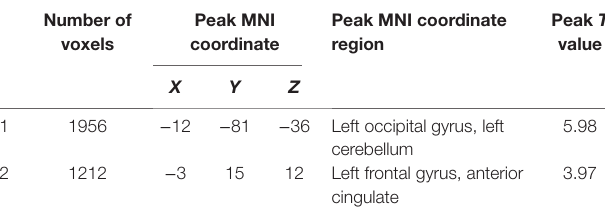
TaBle 2 | Significant CBF difference between baseline and 3 months after CAS with their location.